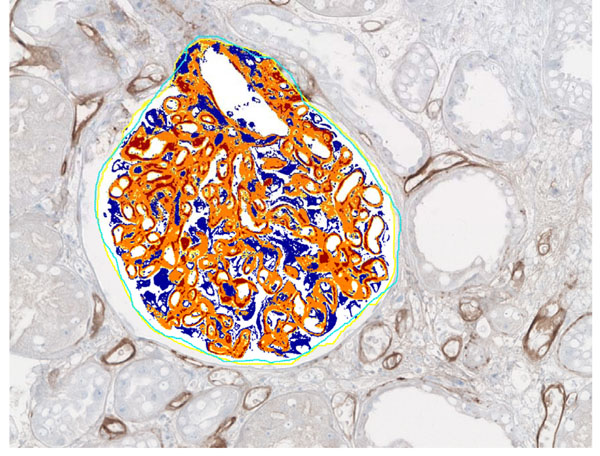
Automated image analysis in glomerular tissue. Manually selected glomeruli were analysed with Aperio Positive Pixel Count algorithm. Different colors indicate the intensity level of C4d positive pixels (red – 3+, orange - 2+, yellow – 1+ ).